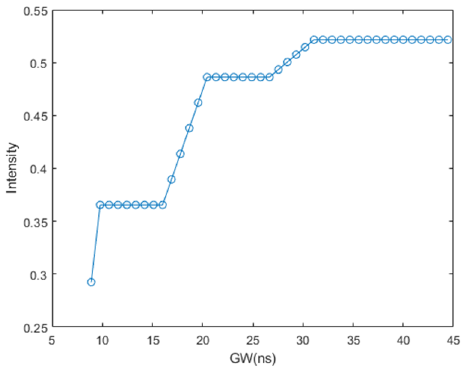
Figure 6. Intensity of the maximal range (6 m) varying with GW.